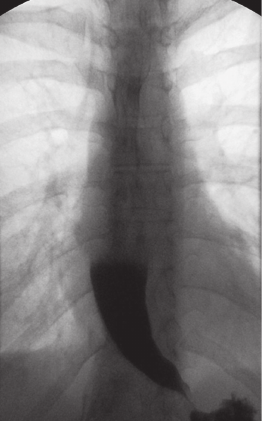
Figure 2: Esophagram showing classic “bird’s beak” tapering with distal narrowing of the esophagus at the gastroesophageal junction with hang-up of